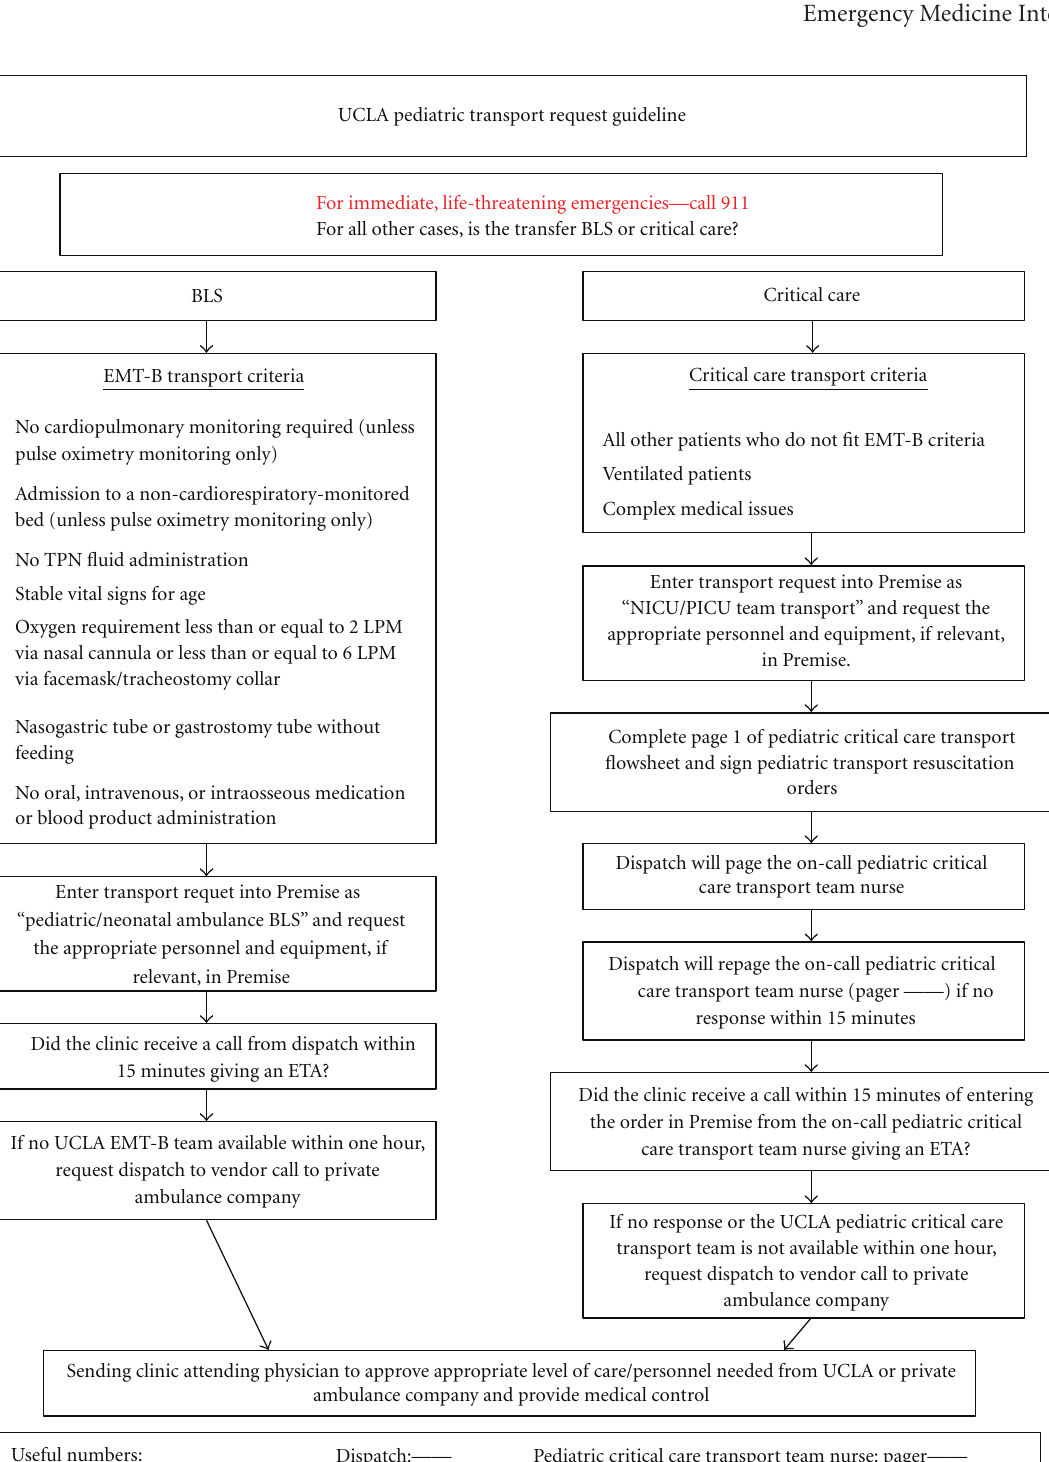
and medical transport for this population. Research in a range of areas is urgently needed for prehospital medicine to adapt to this major demographic transformation. We highlight several suggested areas for further